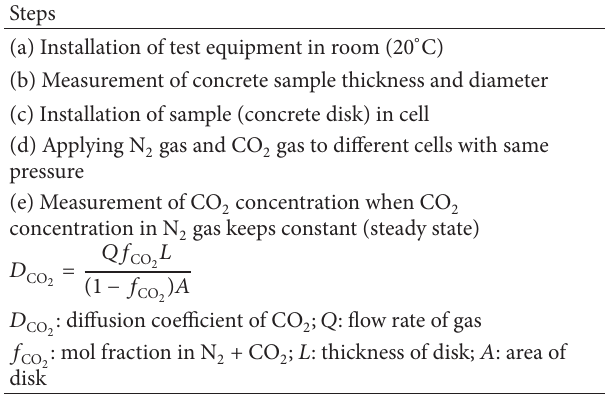
diffusion measurement 2